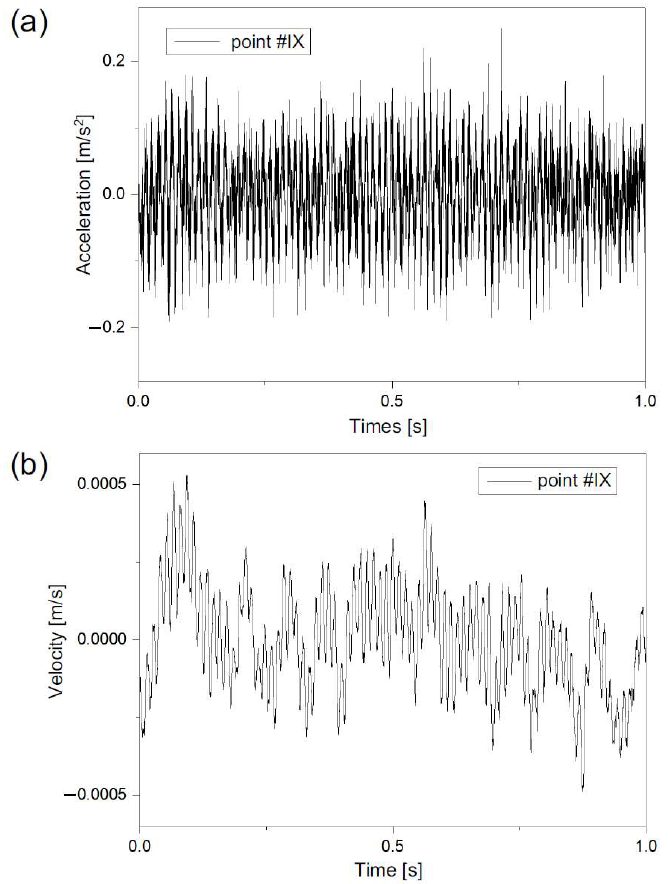
Figure 8. Transformation from acceleration ( a ) to velocity ( b ) for point No. IX in the z direction. Table 1. Multiplication factors of the perception level for various conditions, on the base on interna- tional standards [50]. In bold are factors used in the presented